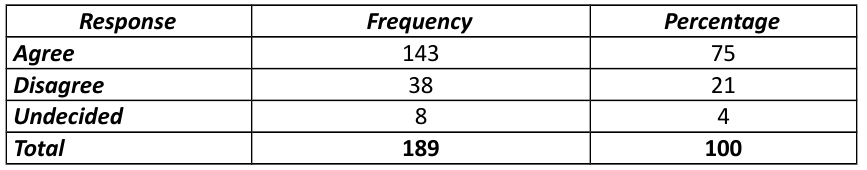
Table 2. Chemistry teacher is available for extra